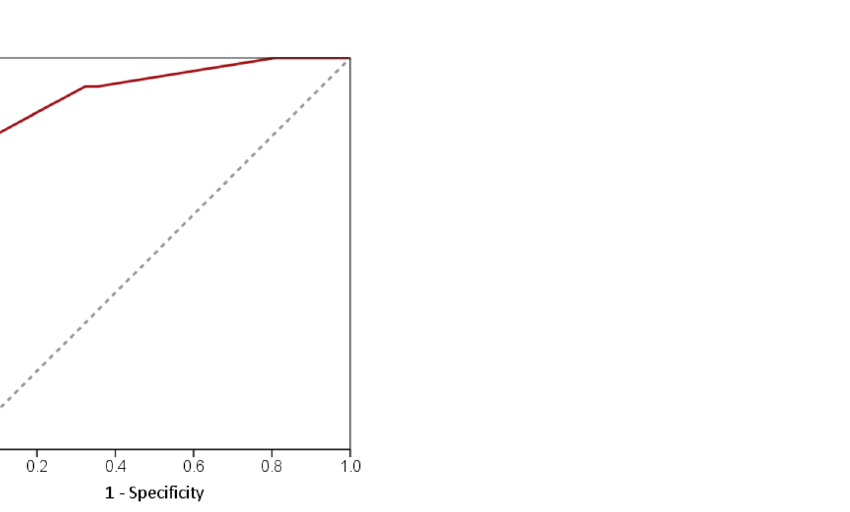
Figure 1. Receiver operating characteristic curve analysis for the diagnosis of reversible cerebral vasoconstriction syndrome (RCVS). Data were analyzed using the derivation data set. Solid red curve represents the RCVS–TCH score with Area Under the Curve (AUC) of 0.929 (95% CI = 0.874–0.984). Diagonal dashed line is a reference line (AUC = 0.5).